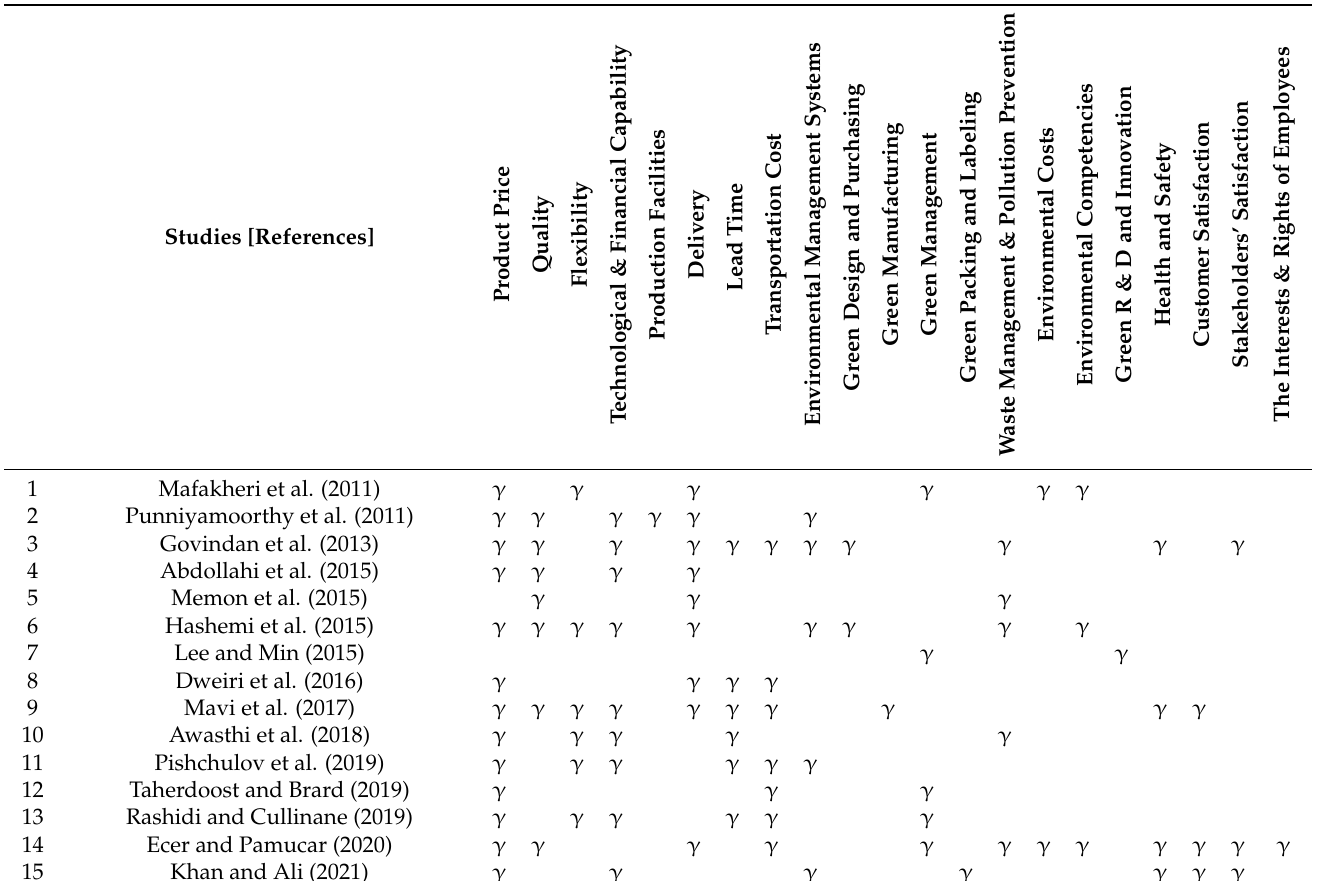
Table 2. A list of factors used in previous